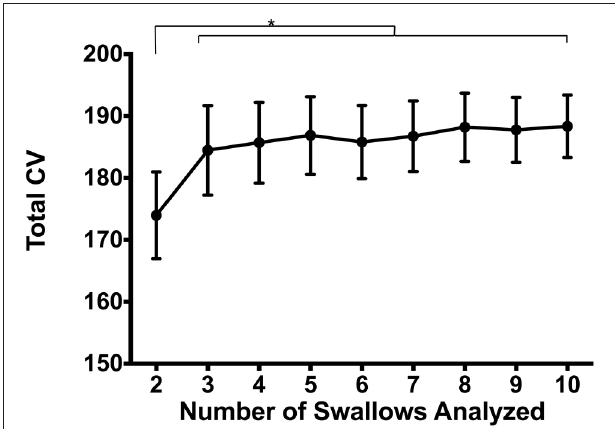
FIGURE 8 | Impacts of number of swallows evaluated on total coefficient of variability (CV). Pressures were significantly less variable when evaluating sets of 2 swallows compared to any other number (* p ≤ 0.03). There were no pairwise differences between 3 and 10 swallows ( p ≥ 0.26). Error bars represent standard error of the